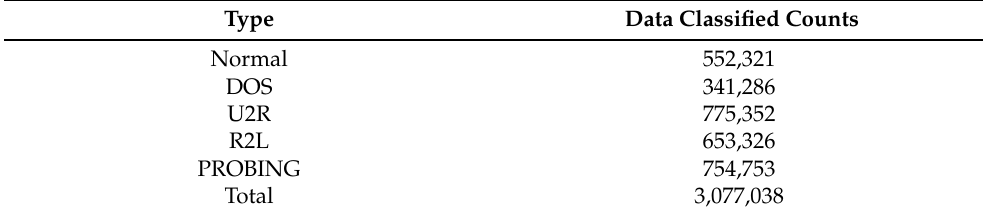
Table 1. Distribution of attacks.